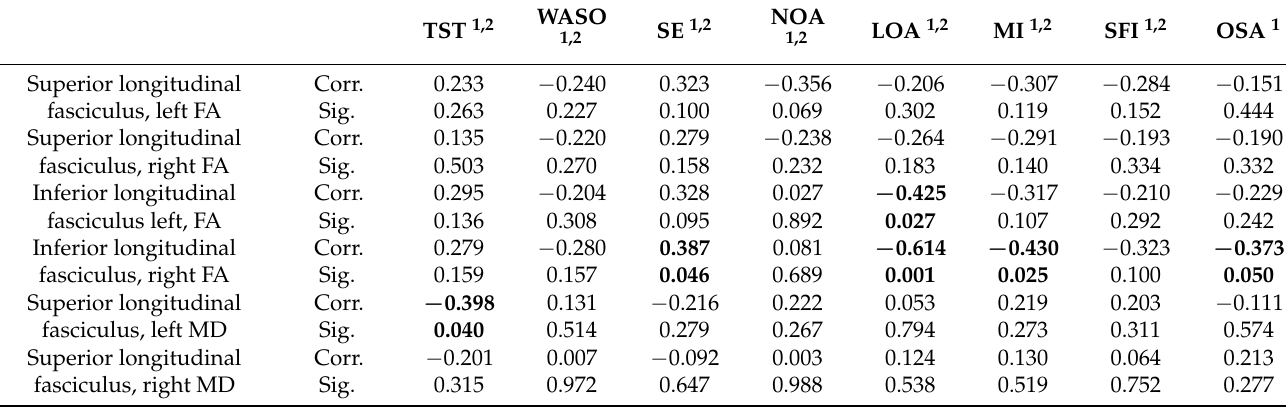
Table 2. Associations between white matter integrity and actigraph sleep indices and diagnosis of obstructive sleep apnea (n =